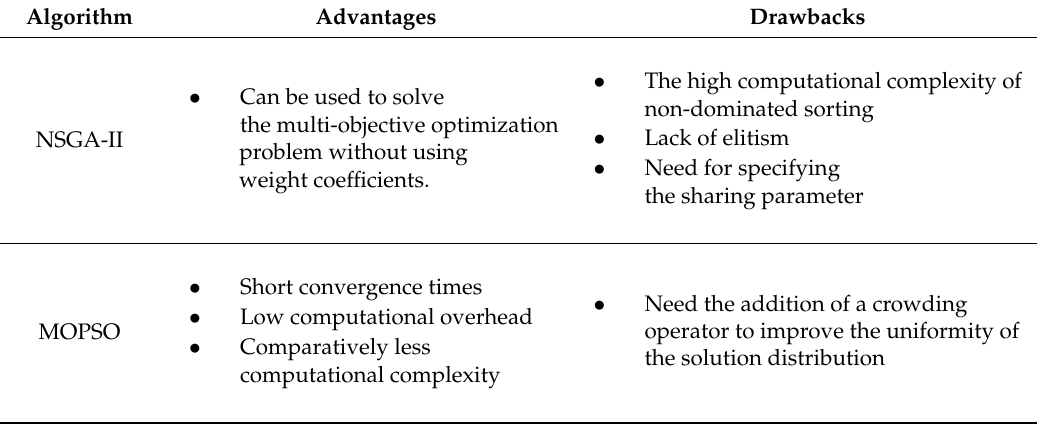
Table 14. Comparison of Non-Dominated Sorting Genetic Algorithm-II (NSGA-II) and Multi-Objective Particle Swarm Optimization (MOPSO) algorithms (complexity basis).